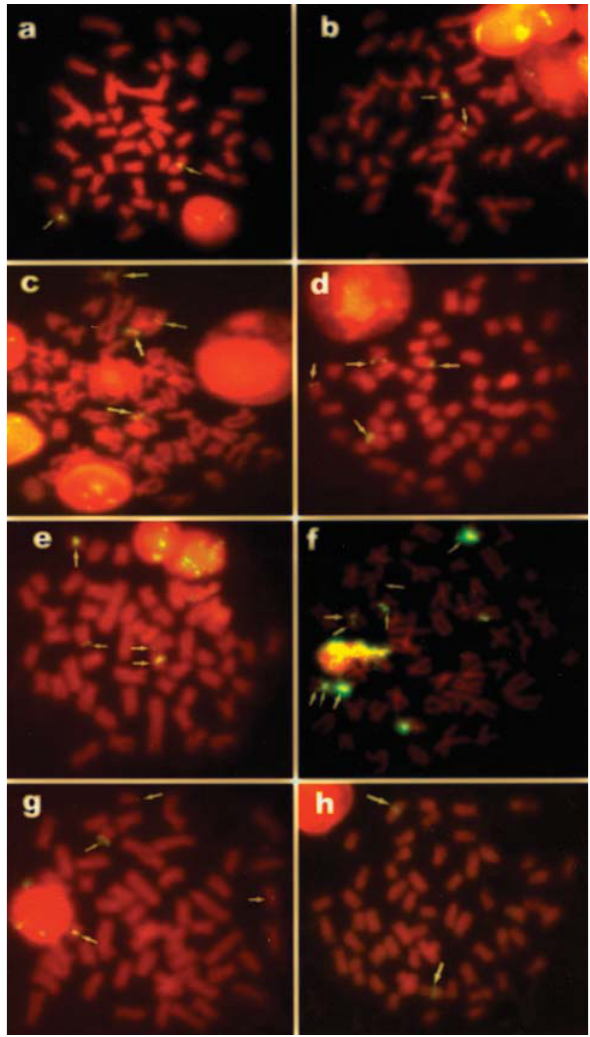
Figure 2 - Localization of 5S rDNA sites (arrows) in (a) Astyanax altiparanae; (b) A.lacustris; (c) A.scabripinnis ;(d) Piabinaargentea ;(e) Orthospinus franciscensis ; (f) Serrapinnus piaba ; (g) S. heterodon ; (h) Myleus